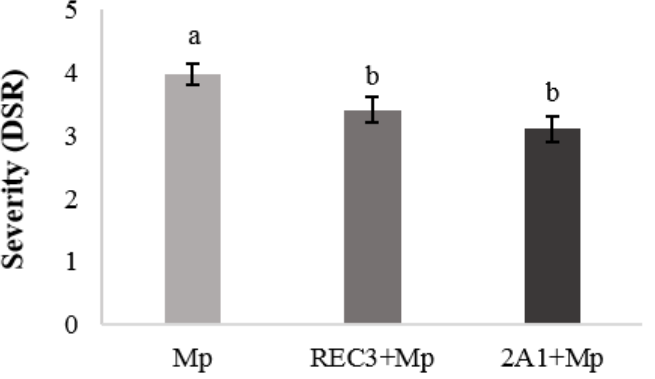
Figure 4. Protection effect exerted by A. brasilense REC3 and 2A1 strains on strawberry plants against M. phaseolina . Disease severity rating (DSR) values at 30 dpi on plants treated with REC3, 2A1, or no-bacteria (Mp). Each value represents the mean (n = 23), and error bars indicate the standard error. Values with different letters indicate significant differences at P ≤ 0.05 .